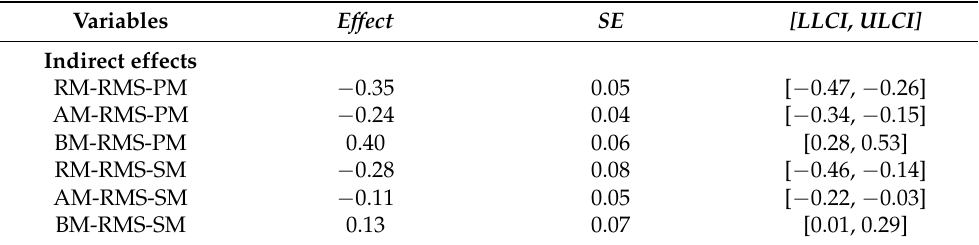
Table 2. Indirect effects of forgiveness on meaning in life through the religious meaning